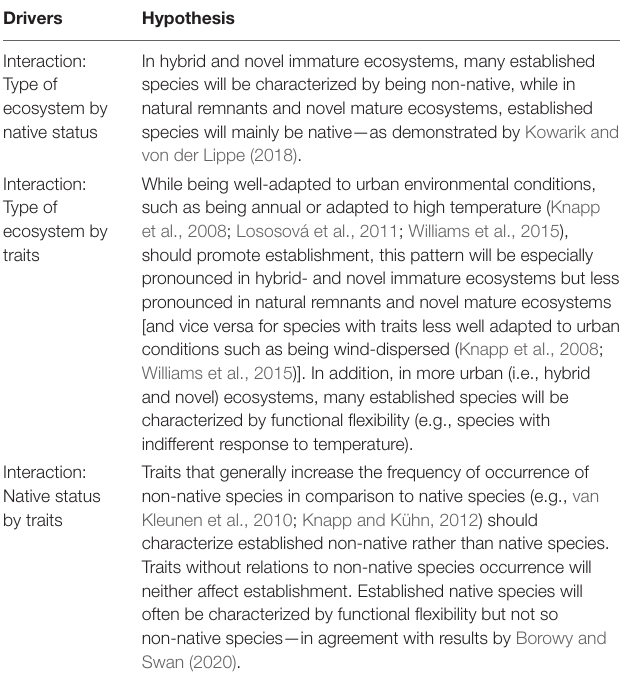
TABLE 1 | Hypotheses about how interactions of species traits with different types of ecosystems (characterized by ecological novelty) and with species native status will influence the establishment of vascular plant species within an urban